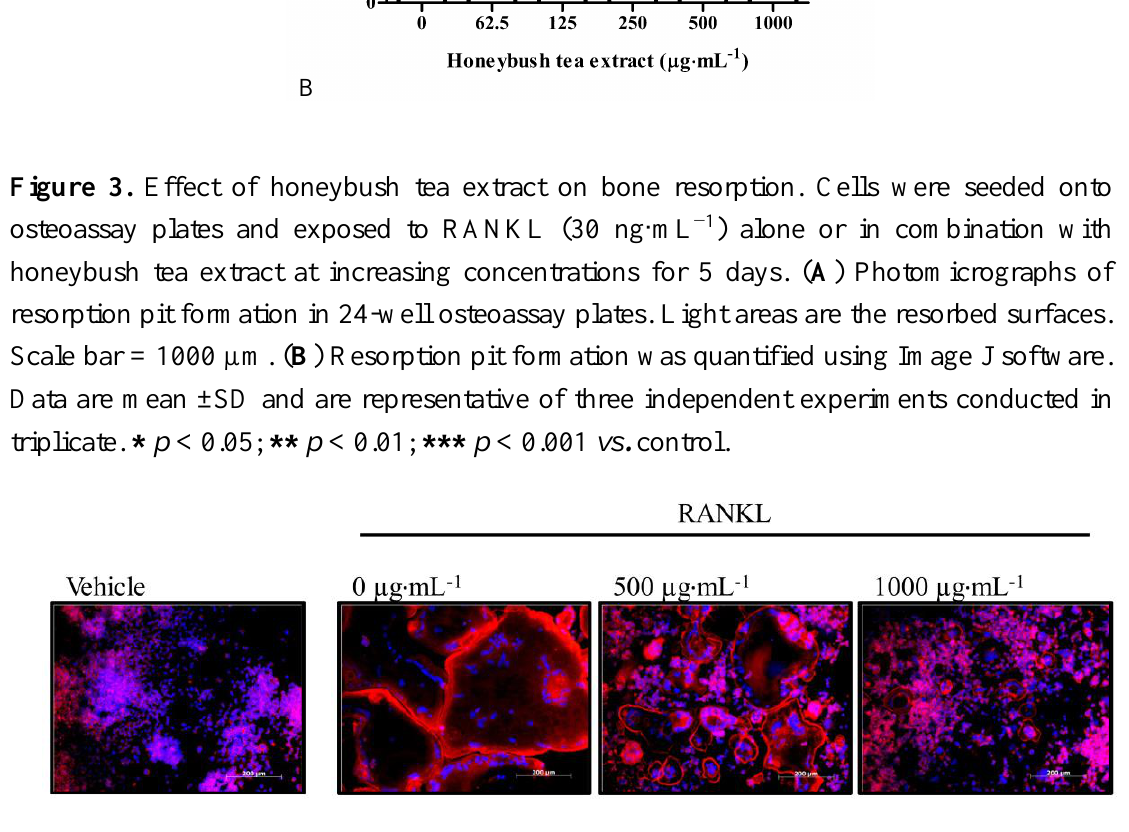
Figure 4. Effect of honeybush tea extract on actin ring formation. Cells were exposed to RANKL (15 ng  mL −1 ) alone or in combination with honeybush tea extract at increasing concentrations for 5 days. Osteoclasts were stained for actin with phalloidin (red) and for nuclei with Hoechst (blue). Scale bar = 200 µ